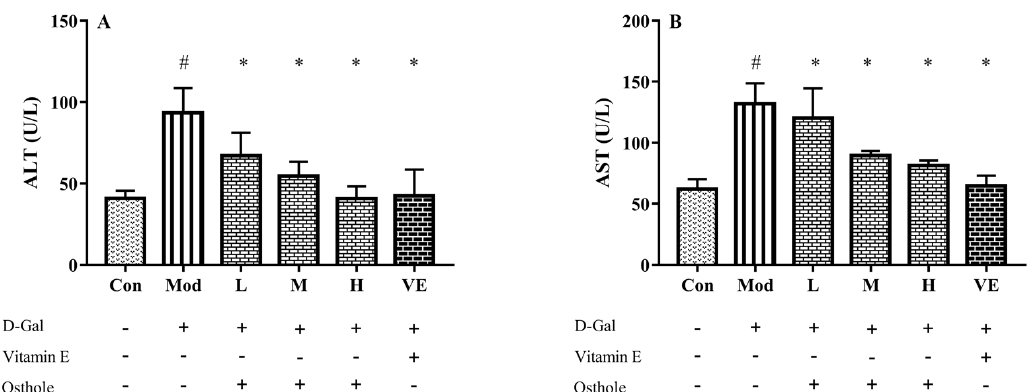
Figure 2. Effects of osthole on serum activity or levels of ( A ) ALT and ( B ) ASP in mouse D-Gal- induced aging model. #, p < 0.01 for comparison of model group with control group. *, p < 0.01 for comparison of experimental group with model group.